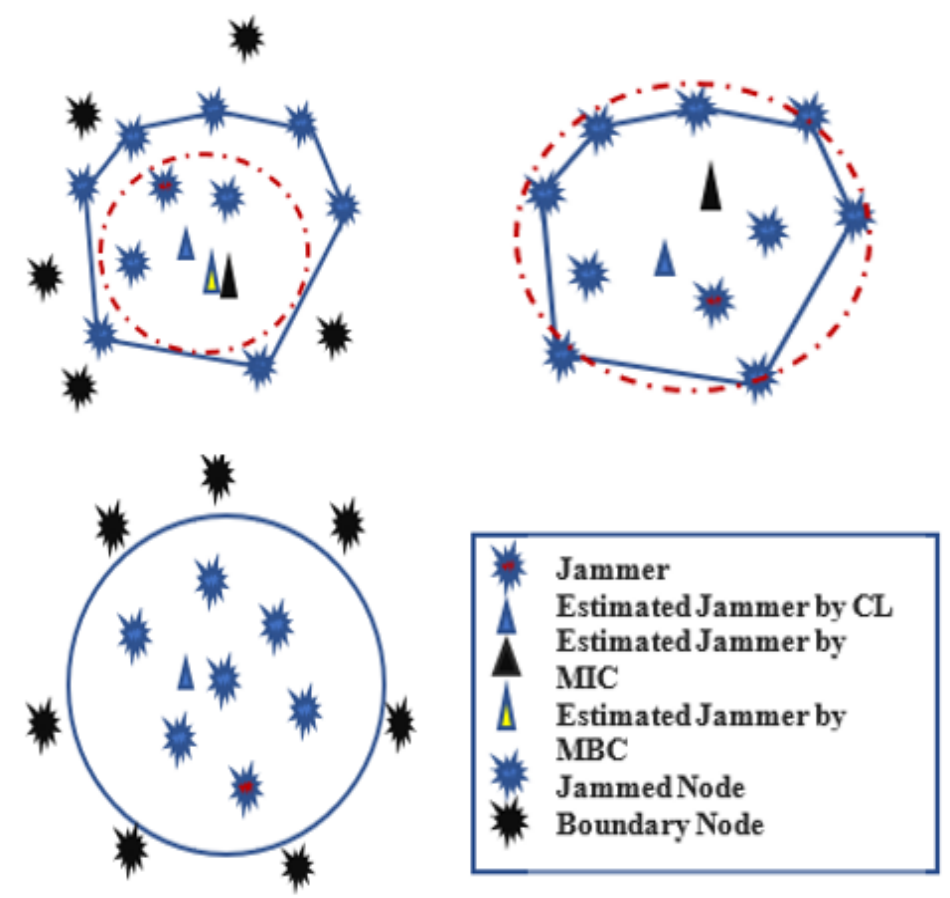
Figure 23. Double circle localization (DCL).